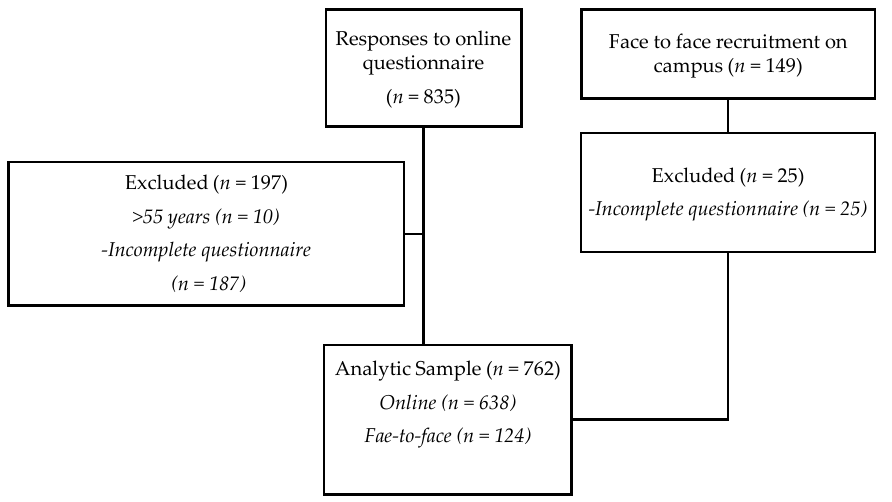
Figure 1. Participant flow for study recruitment face-to-face and online.